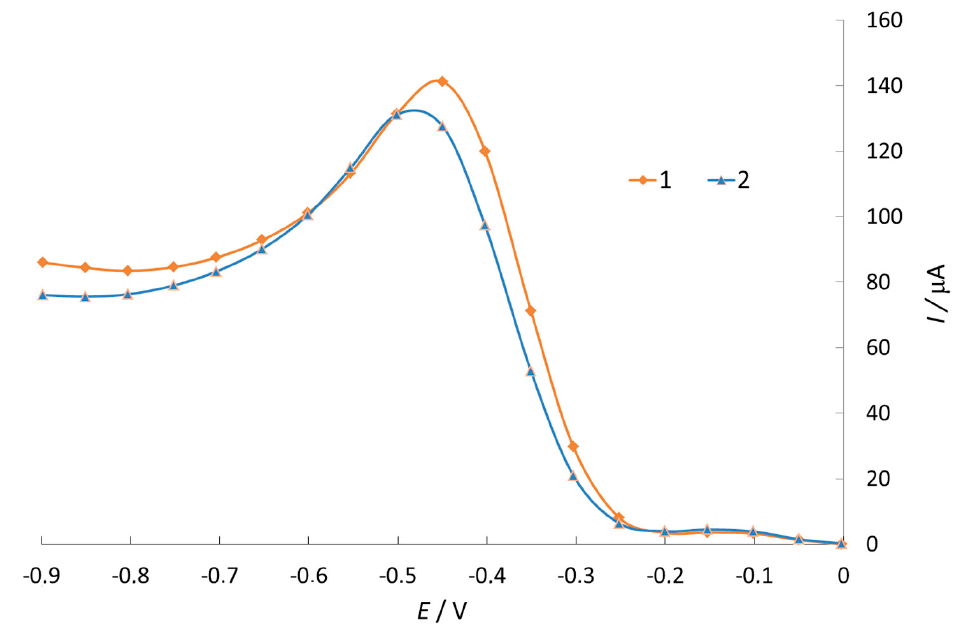
Figure 2. Voltammogram of ER O 2 current 85% ethanol solution. 1—Background curve (0.1N NaClO 4 ); 2—In the presence of 0.1% phenothiazine.